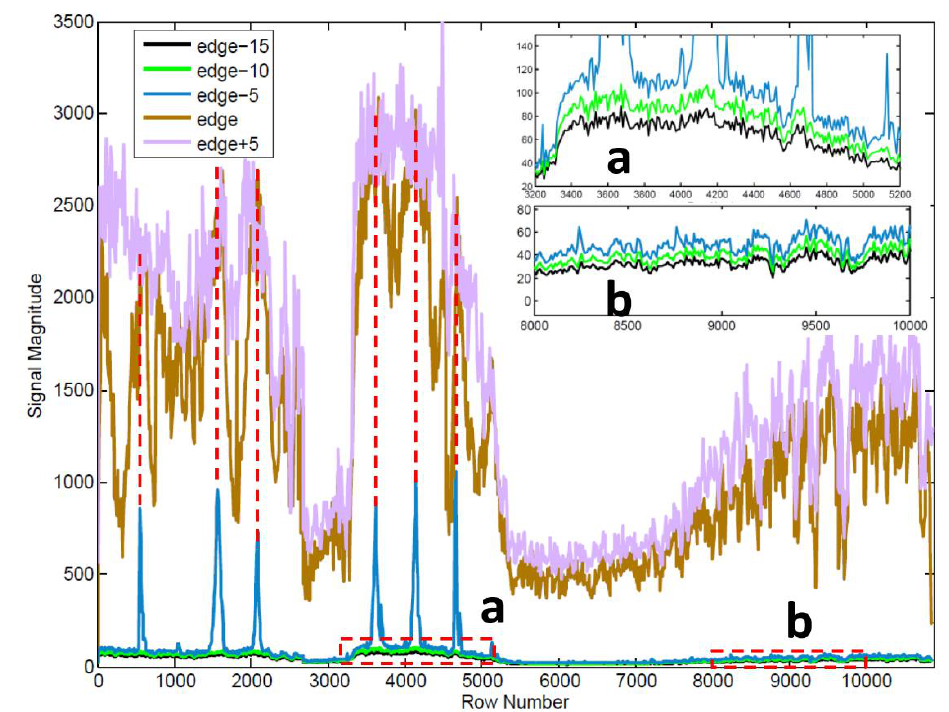
Figure 8. Signal magnitude (digital number (DN) value) along the BM edge, effective signal region, and black margins in the left side of image shown in Figure 6e. In the legend, ‘edge’ indicates the signal from column corresponding to BM edge. ‘edge + 5’ indicates the signal from the fifth column to the right side (signal region) of edge. ‘edge-m’ indicated the signal from the m-th column to the left side (black margin) of edge. Location of the embedded figure ( a , b ) is marked with a red dashed rectangle using the same marking indices. Vertical dashed red lines indicate the column, which shows good correlation between strong backscattered signals and large noise signals in BM.